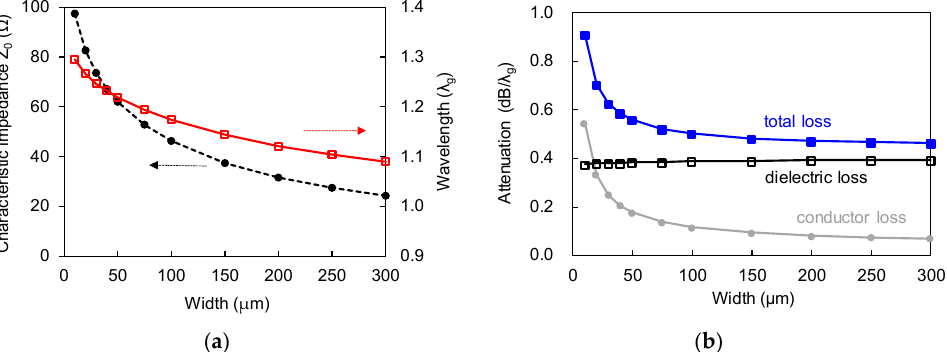
Figure 2. Simulated characteristics of the microstrip line as a function of signal width at 90 GHz. ( a ) Characteristic impedance Z 0 and wavelength λ g . ( b ) Attenuation per a wavelength ( λ g